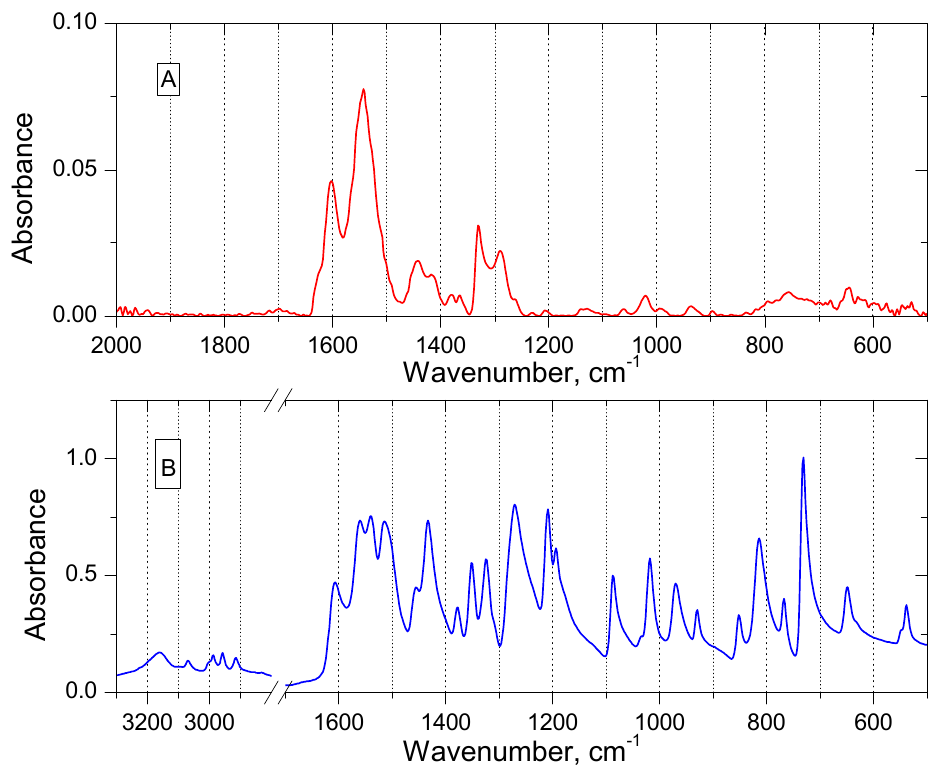
Figure 7. FT ‐ IR spectra of the Pd(II) ‐ chloro ‐ EDAB ‐ acac salt ( A ) and EDAB ‐ acac ( B ) solution in meth ‐ Figure 7. FT-IR spectra of the Pd(II)-chloro-EDAB-acac salt ( A ) and EDAB-acac ( B ) solution in methylene ylene chloride.